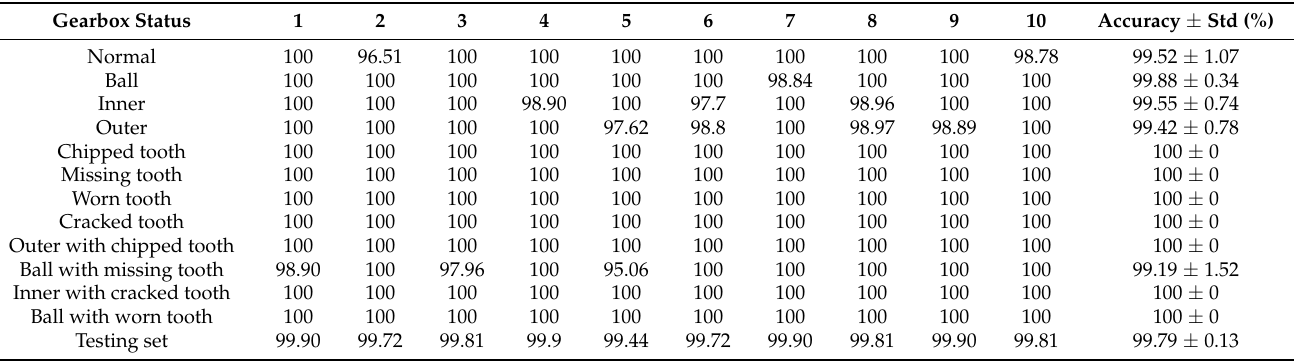
Table 4. Results of ten parallel experiments of